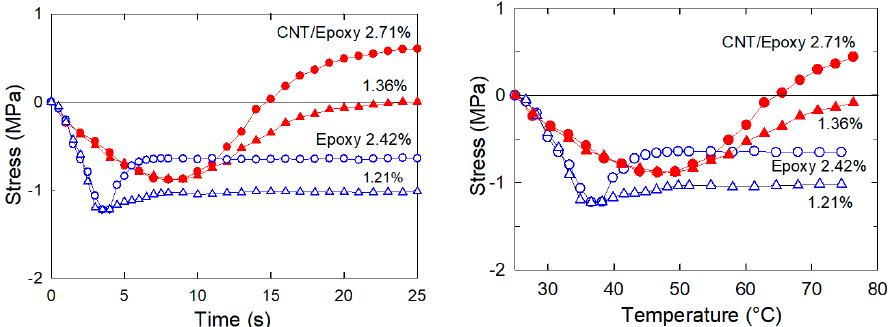
Figure 3. Time − dependent ( left ) and temperature − dependent ( right ) variations in stress during a heating of the MWCNT nanopaper/epoxy and epoxy strips from the temperature of 25 ◦ C to 75 ◦ C at the fixed strain denoted in the